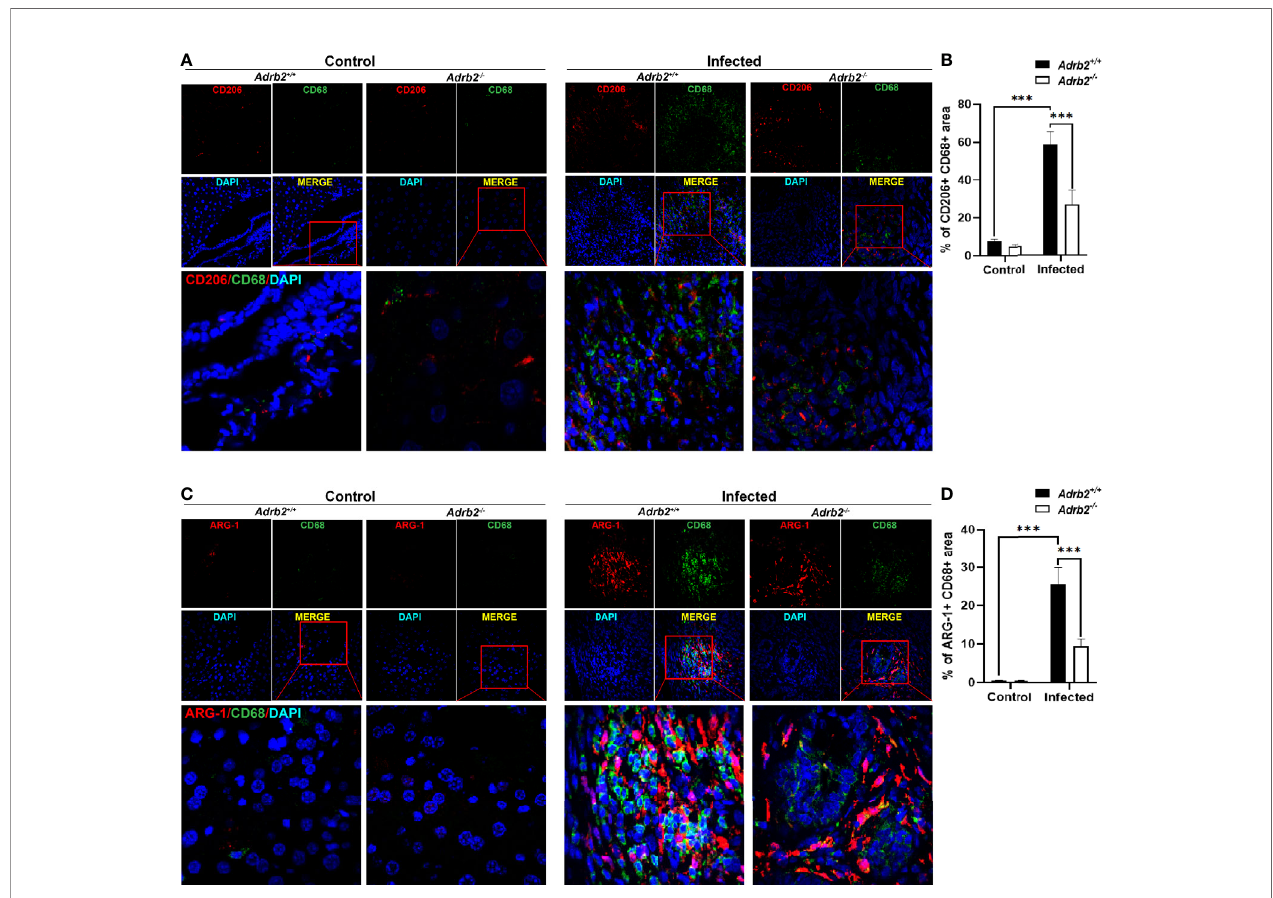
FIGURE 4 | Adrb2 − / − signi fi cantly decreased alternatively activated macrophages in fi ltration in Clonorchis sinensis infection. The experimental setup of the in vivo model used n = 4 mice in the control group and four mice in the infected group. The mice were divided into control Adrb2 +/ + , Adrb2 − / − and infected Adrb2 +/ + , Adrb2 − / − . (A, B) The immuno fl uorescence co-staining of CD68 and CD206 indicating the alternatively activated macrophages revealed that there was a strong in fi ltration of alternatively activated macrophages in infected mice than that observed in control mice; however, the knocking out of b 2-AR induced a decrease in alternatively activated macrophages in fi ltration. (C, D) In vivo Immuno fl uorescence co-staining of CD68 and Arginase-1. The co-expression of CD68 and Arginase-1 indicating AAMs showed that there was a very low expression of CD68 and Arginase-1 in the liver of control mice. The infection of mice with C. sinensis resulted in a signi fi cant increase in the expression of arginase in the liver. Moreover, activated macrophages expressed arginase-1. However, Adrb2 − / − mice infected with C. sinensis decreased the expression of positive CD68 and Arginase-1. Compared with indicated groups, *** P <